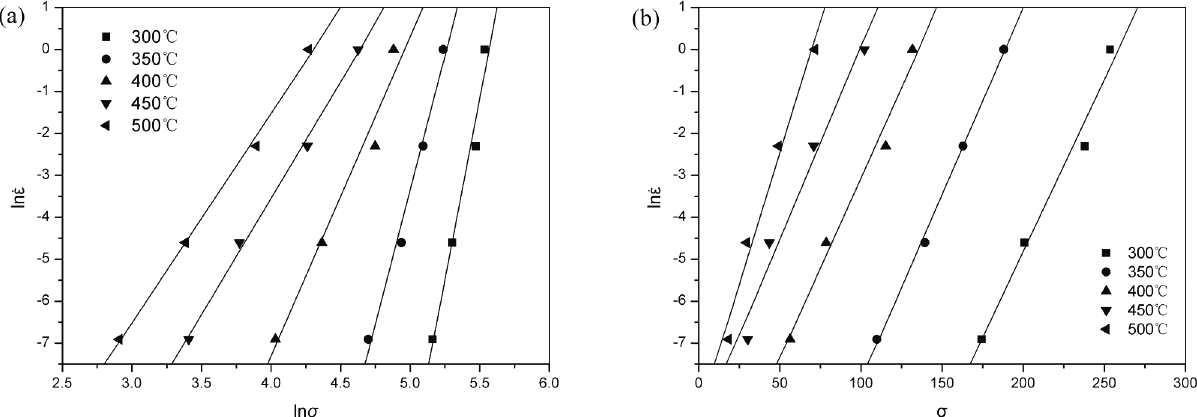
Fig. 2: Relationships between: (a) ln ε  – ln σ ; (b) ln ε  – σ